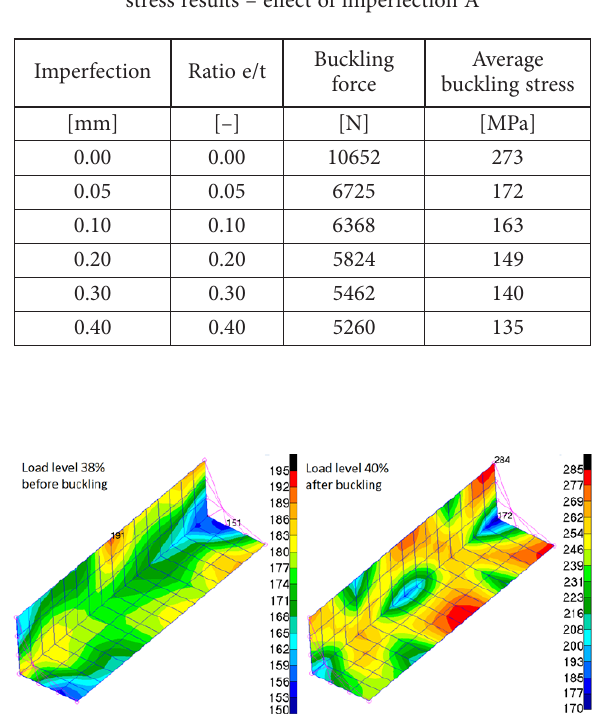
Table 2. Numeric comparison of buckling force and buckling